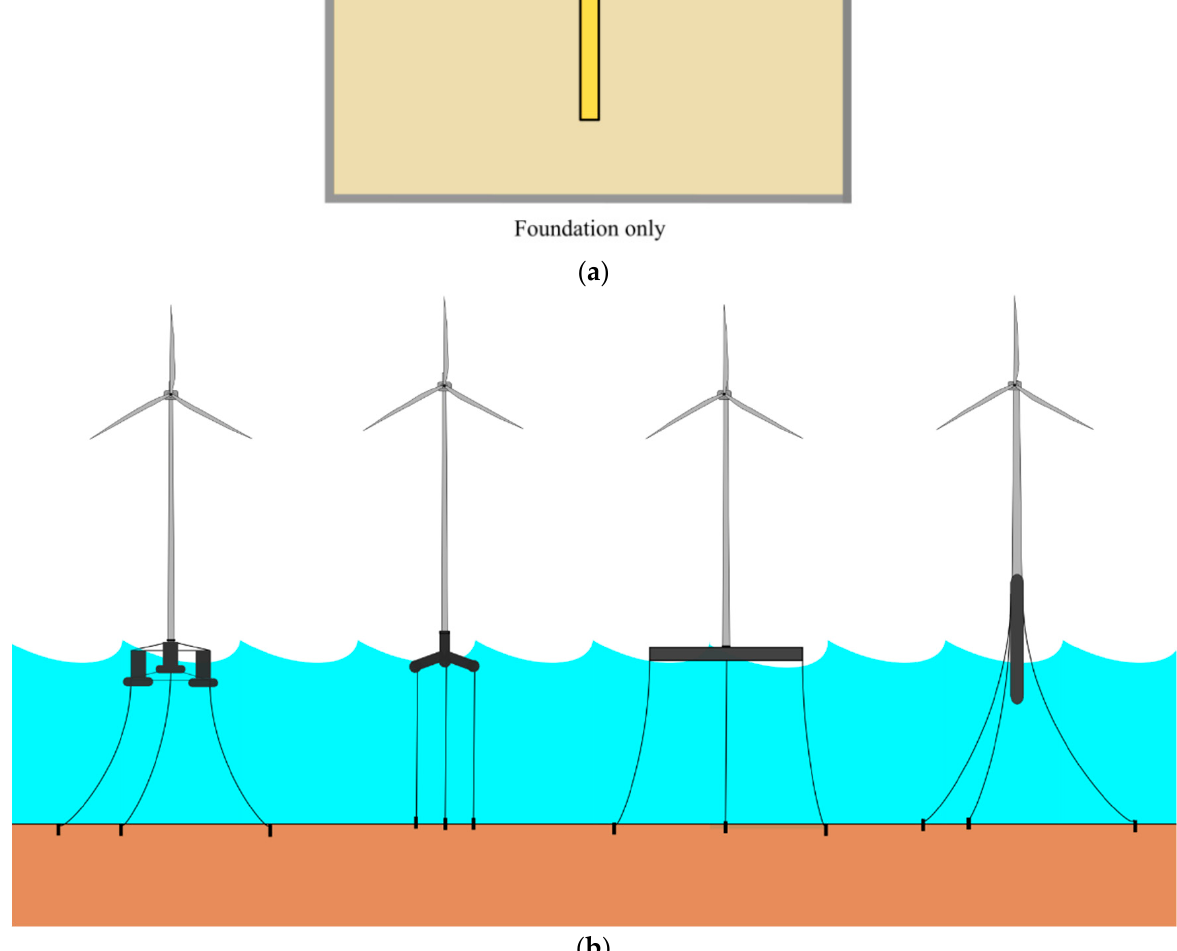
Figure 13. ( a ) “Foundation only modelling”—Type 1 technique. ( b ) Examples where Type 1 modelling is appropriate.